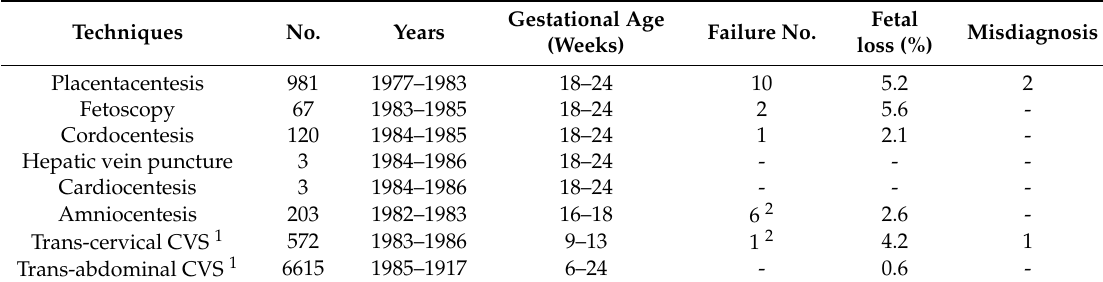
Table 2. Invasive prenatal diagnoses of β -thalassemia in Sardinia: 8564 in 40 years (1977–2017).